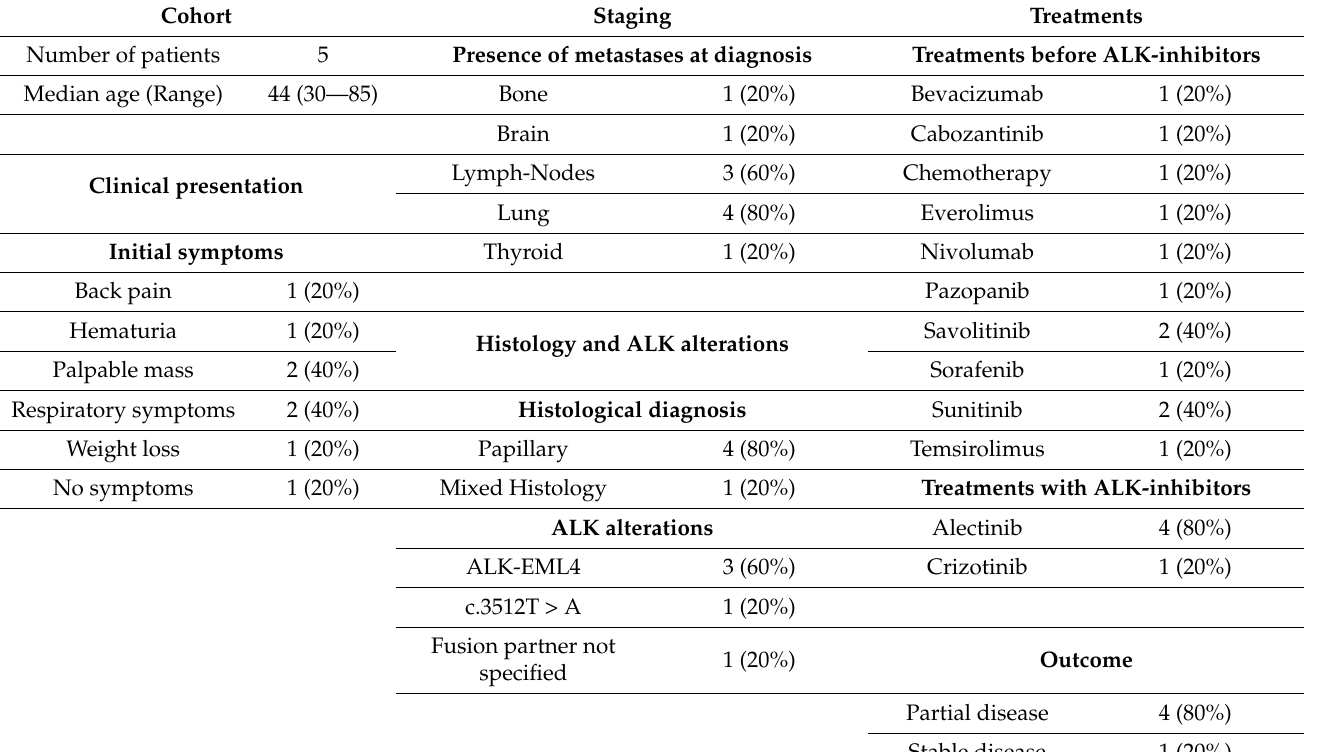
Table 2. Results of quantitative analysis of variables extracted by included